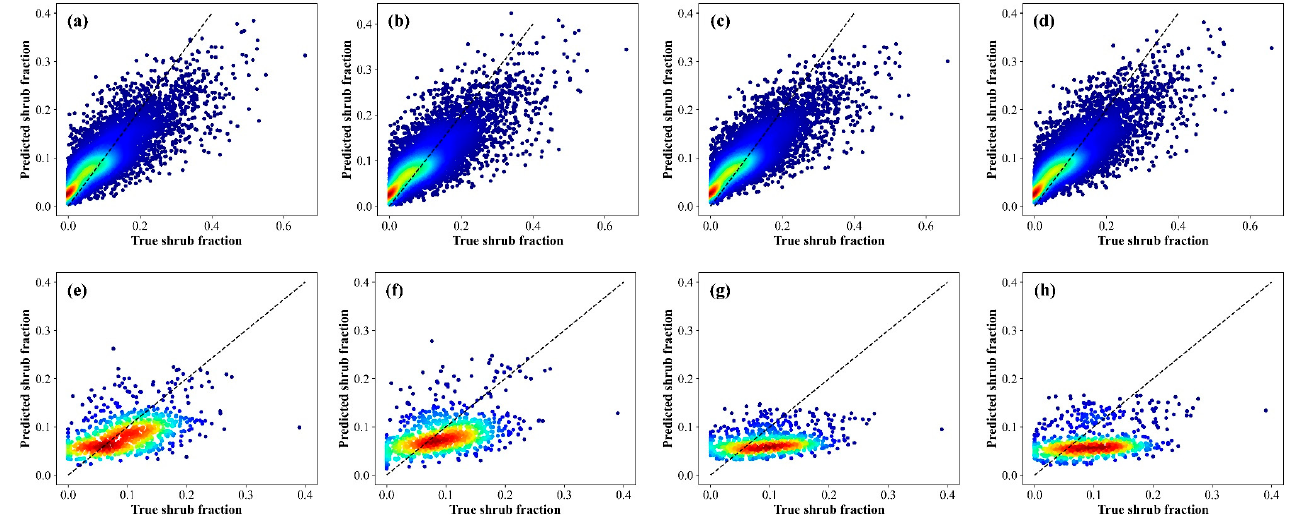
Figure 9. The scatter plots of the true and predicted shrub coverage of the validation samples ( a – d ) and test samples ( e – h ) based on Stgy.1–4.